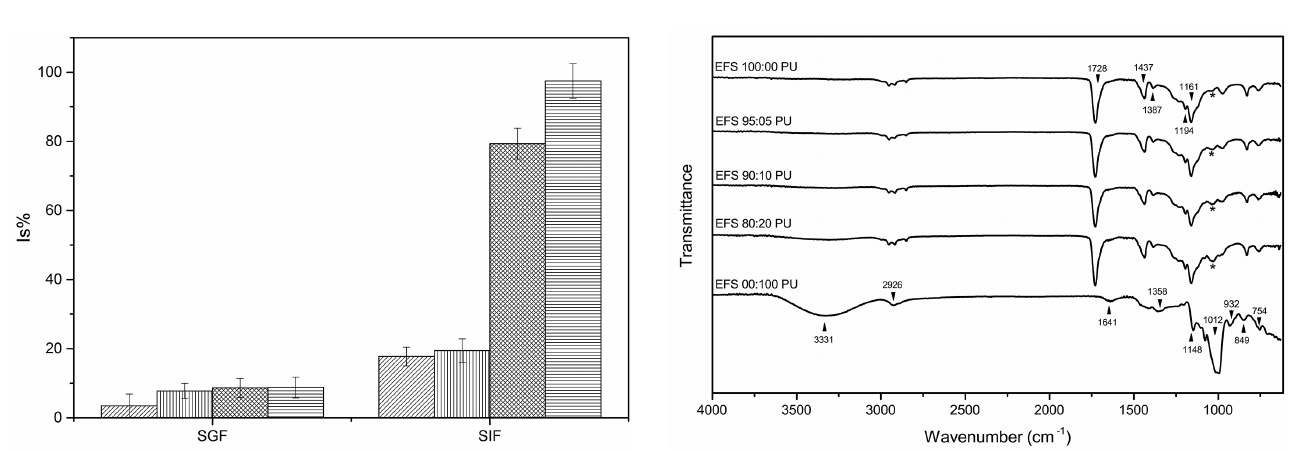
FIGURE 3 - FTIR of polymethacrylate films that contained 0-20% PU and pure PU.